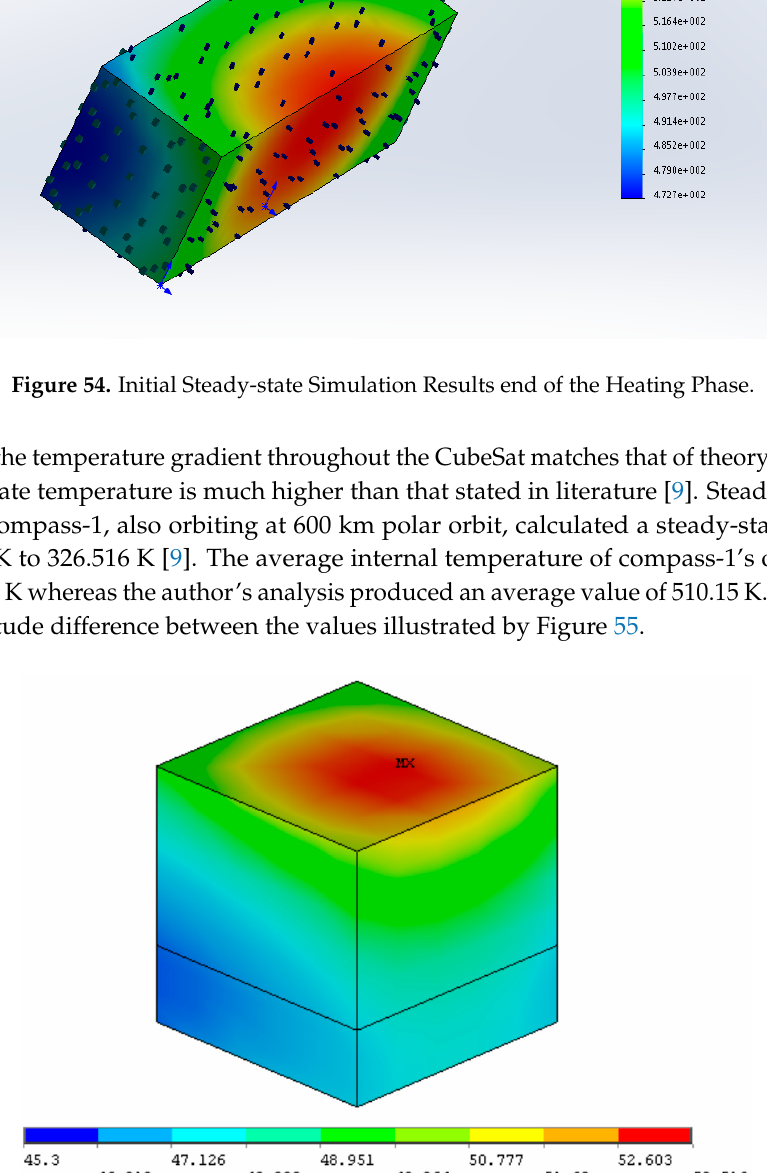
Figure 53. Heat Dissipation to Background Space using Surface to Surface Modelling.